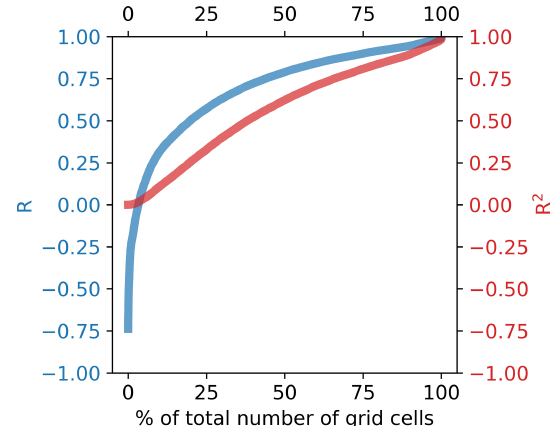
Figure 8. Sorted R and R 2 values from all grid cells calculated from global shelf-sea SST simulation correlation with satellite SST (Fig.